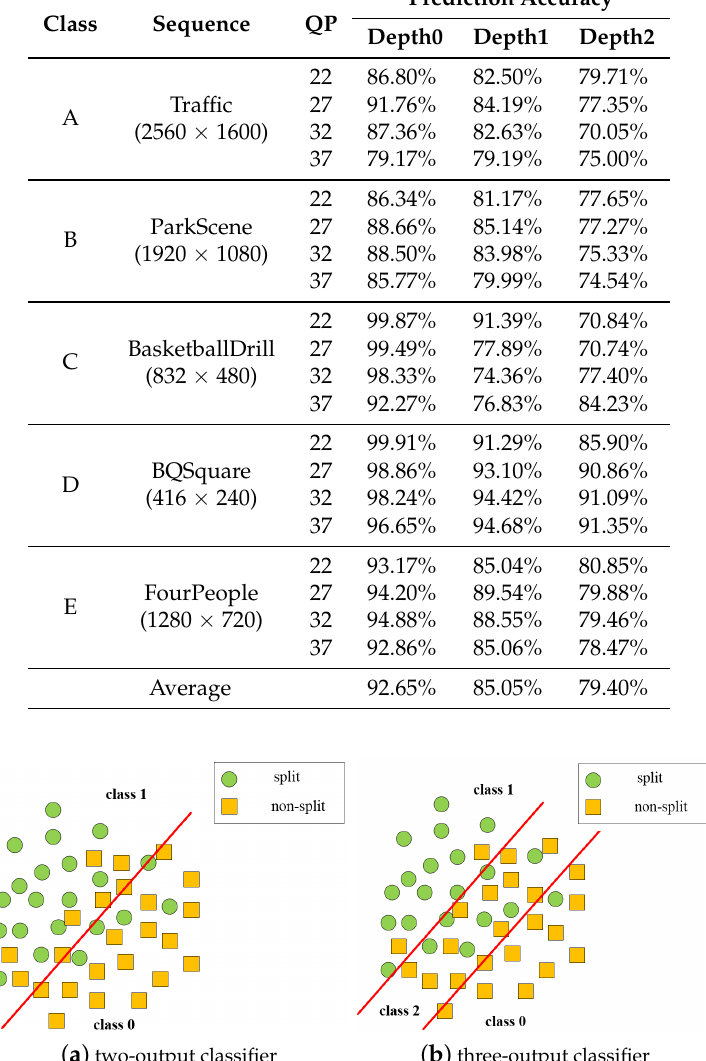
Figure 9. Classification edge of binary output and three-output classifiers. Class 0 represents non-split CUs, while class 1 represents splitting and class 2 is the CU category in which rate-distortion optimization (RDO) is performed. Red line is the classification edge between different